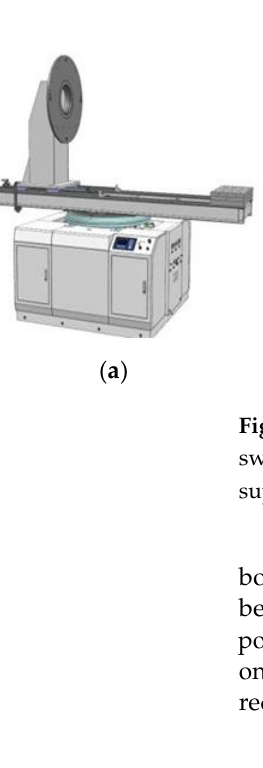
Figure 8. (a) The up view of the three-dimensional model of multi-station switching device. ( b )The bottom view of the three-dimensional model of multi-station switching device.